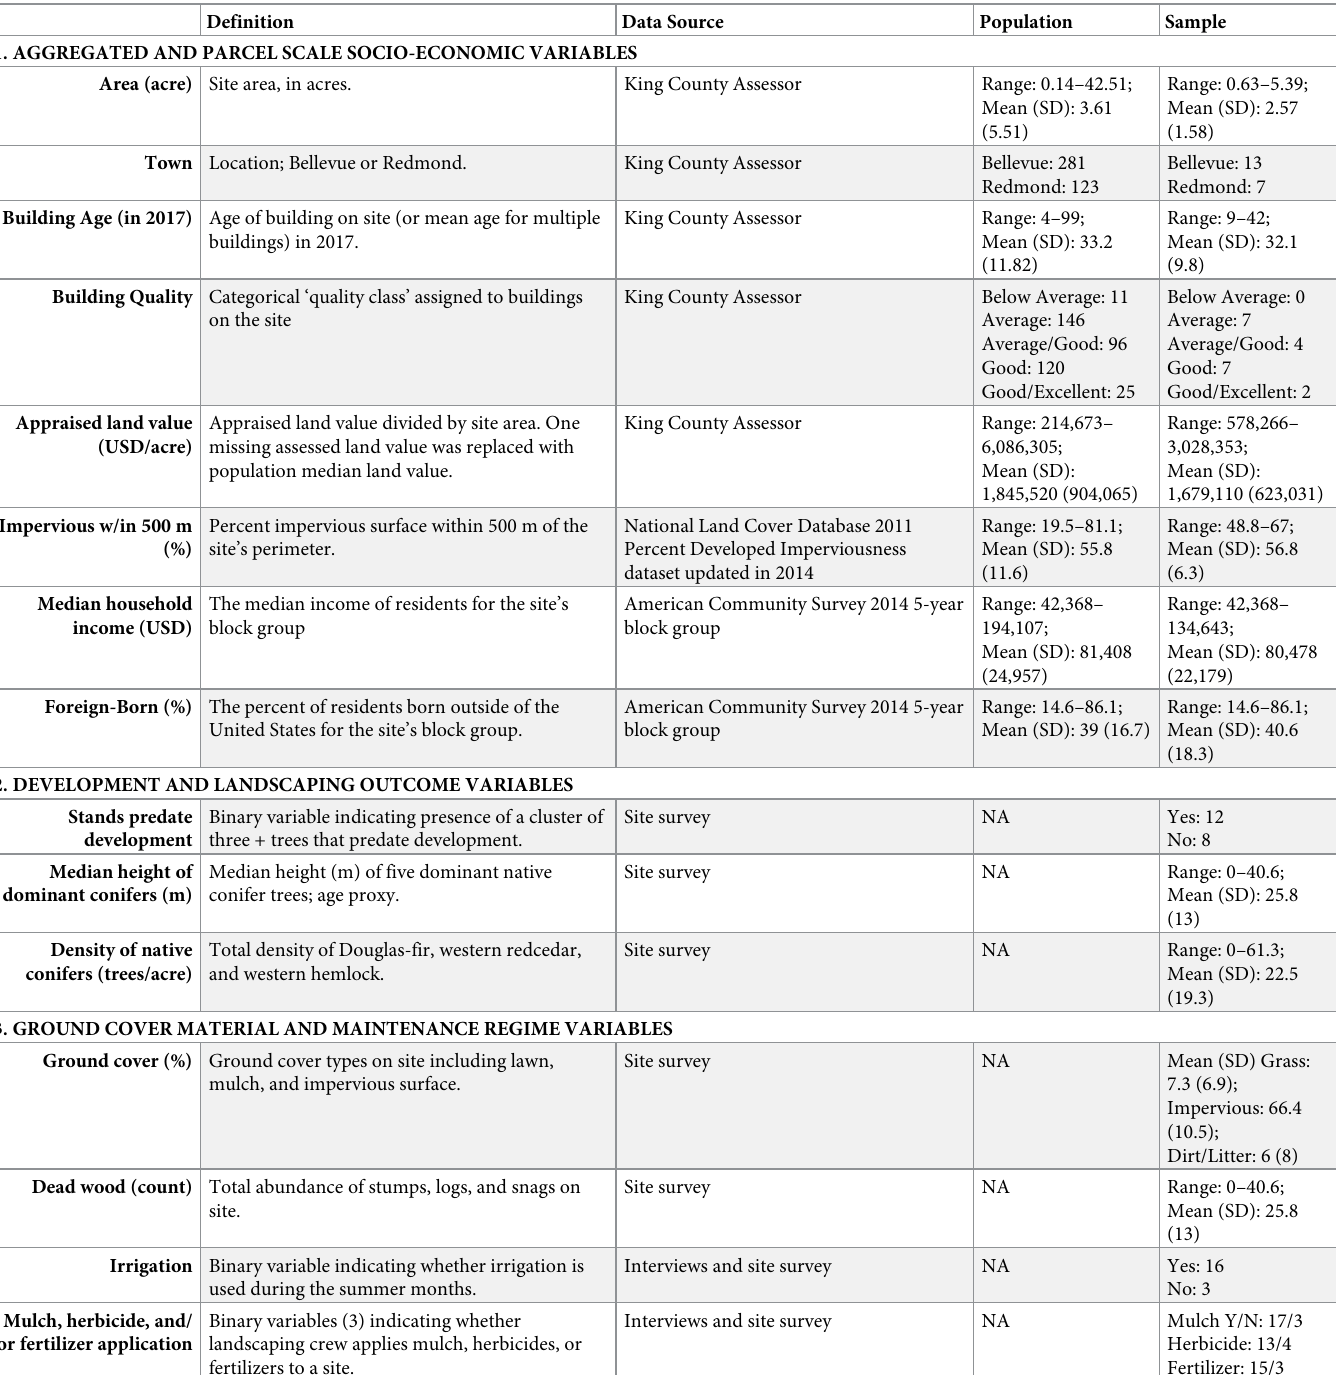
Table 2. Definition of independent variables used in PERMANOVA and correlation analysis